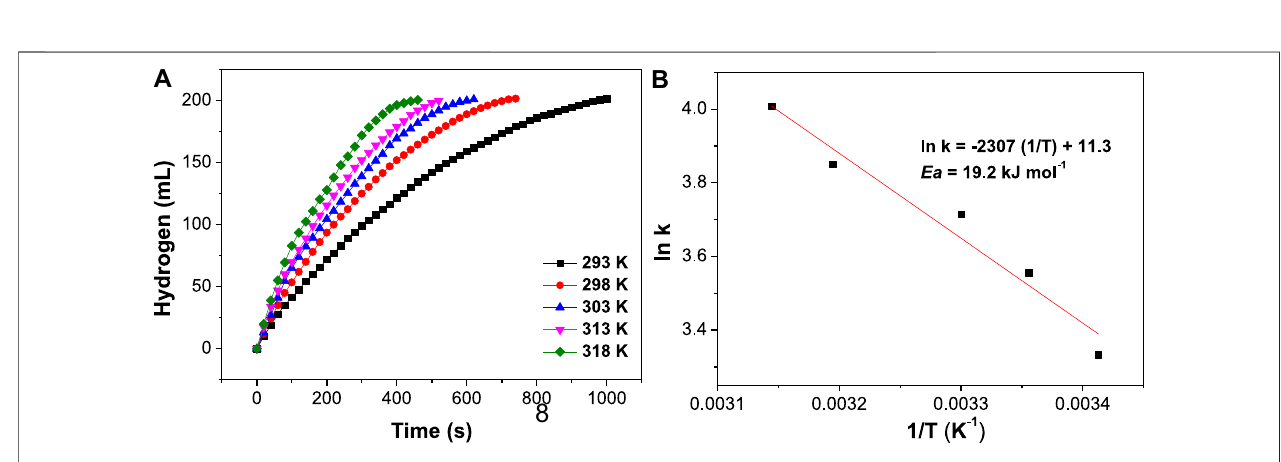
FIGURE 6 | Effects of reaction temperatures on hydrogen evolution when NiCo-1/CF acts as a catalyst (A) and its corresponding Arrhenius plot (B) .